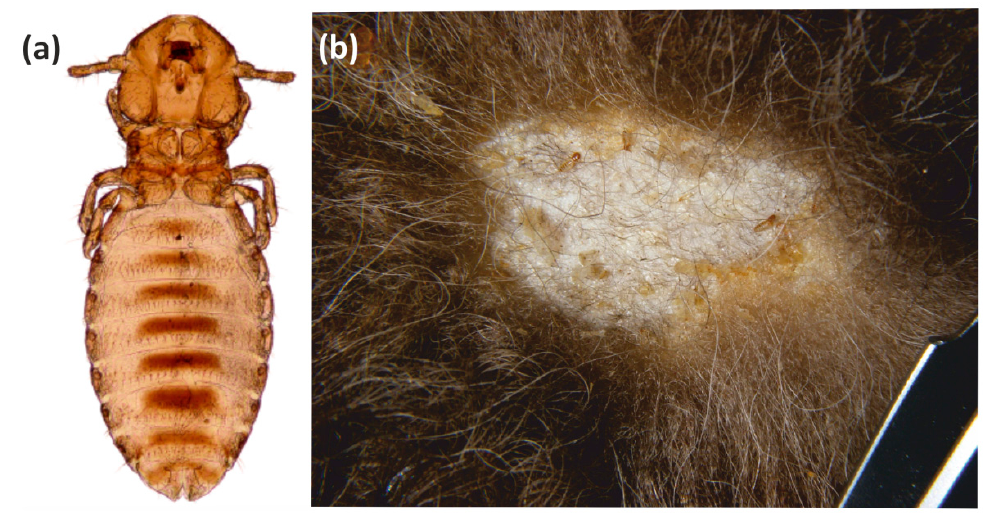
Figure 5. Bisonicola sedecimdecemrii : ( a ) Female; ( b ) Mallophagosis —cluster (nest) of chewing lice in the winter season.